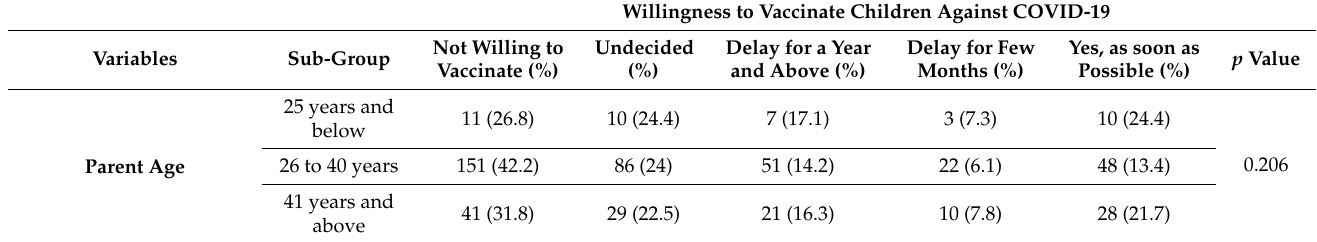
Table 2. Association between demographic variables with parents’ willingness to vaccinate their children against